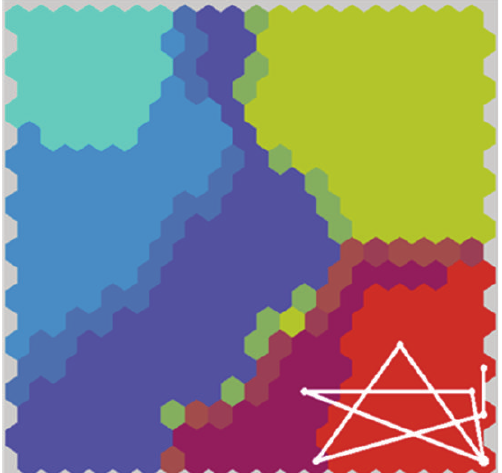
Figure 17: Mapping of perimeter image.